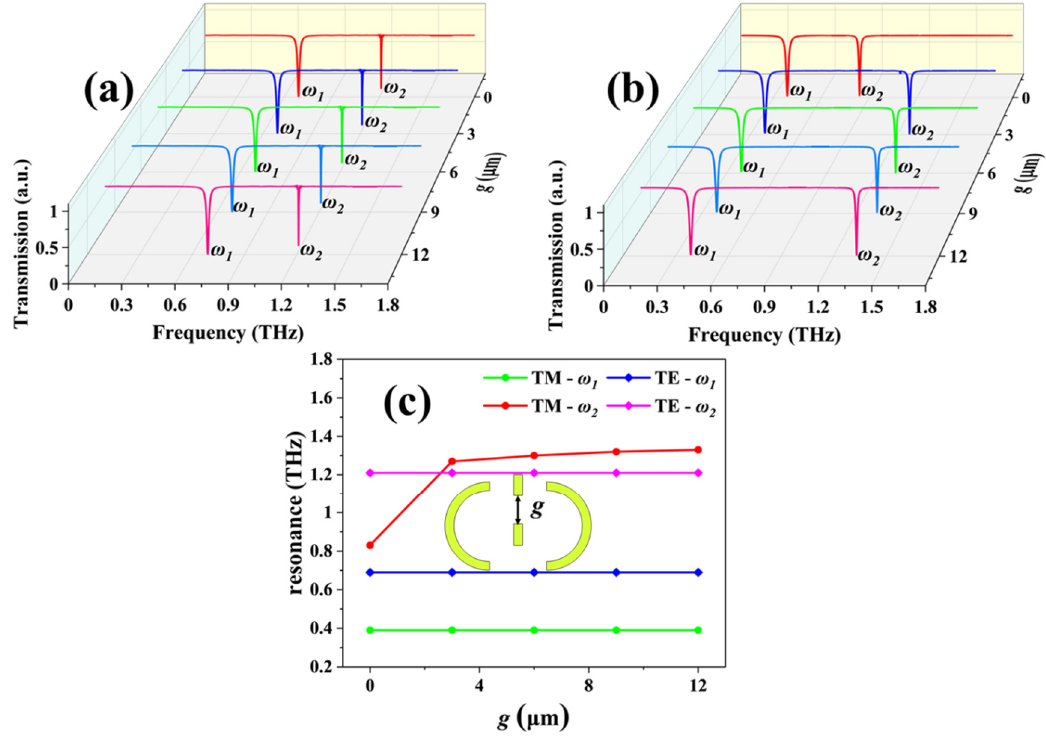
Figure 7. Transmission spectra of an eSRR with different g values in ( a ) TE and ( b ) TM modes. ( c ) The relationships of resonances and g values in ( a , b ).